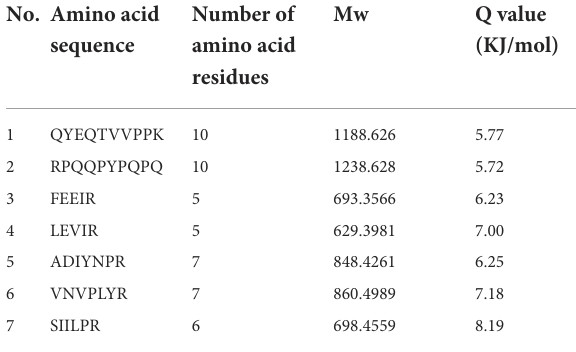
TABLE 8 Result of peptides sequence of WGH-Try20M determined by